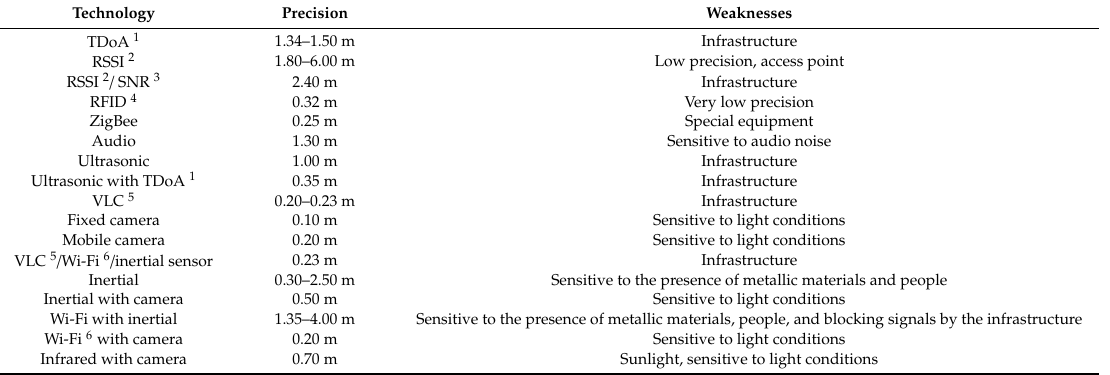
Table 2. Comparison of leading indoor positioning